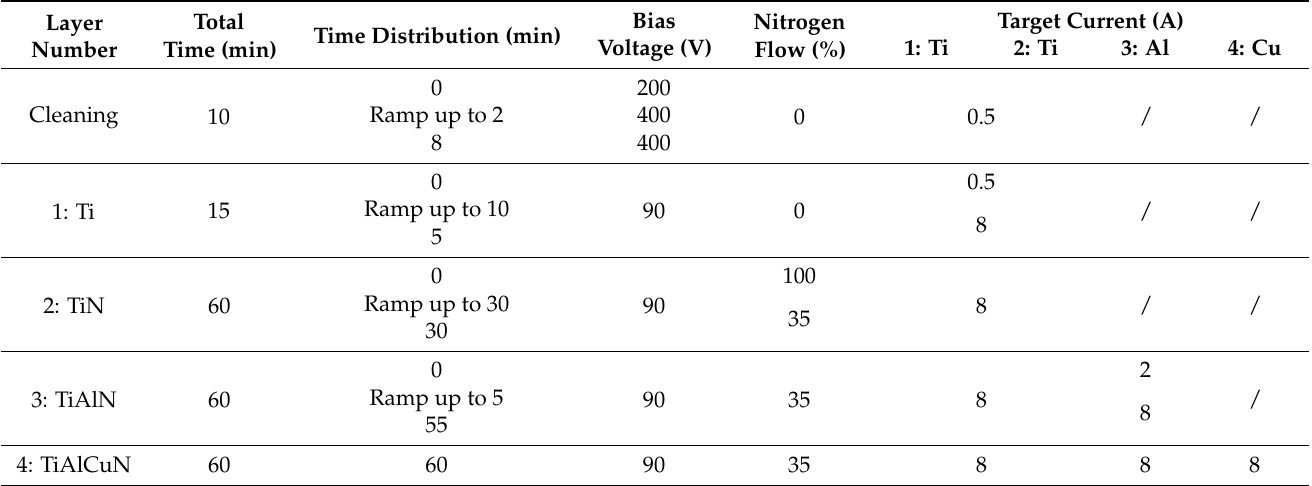
Table 2. Coating deposition parameters.